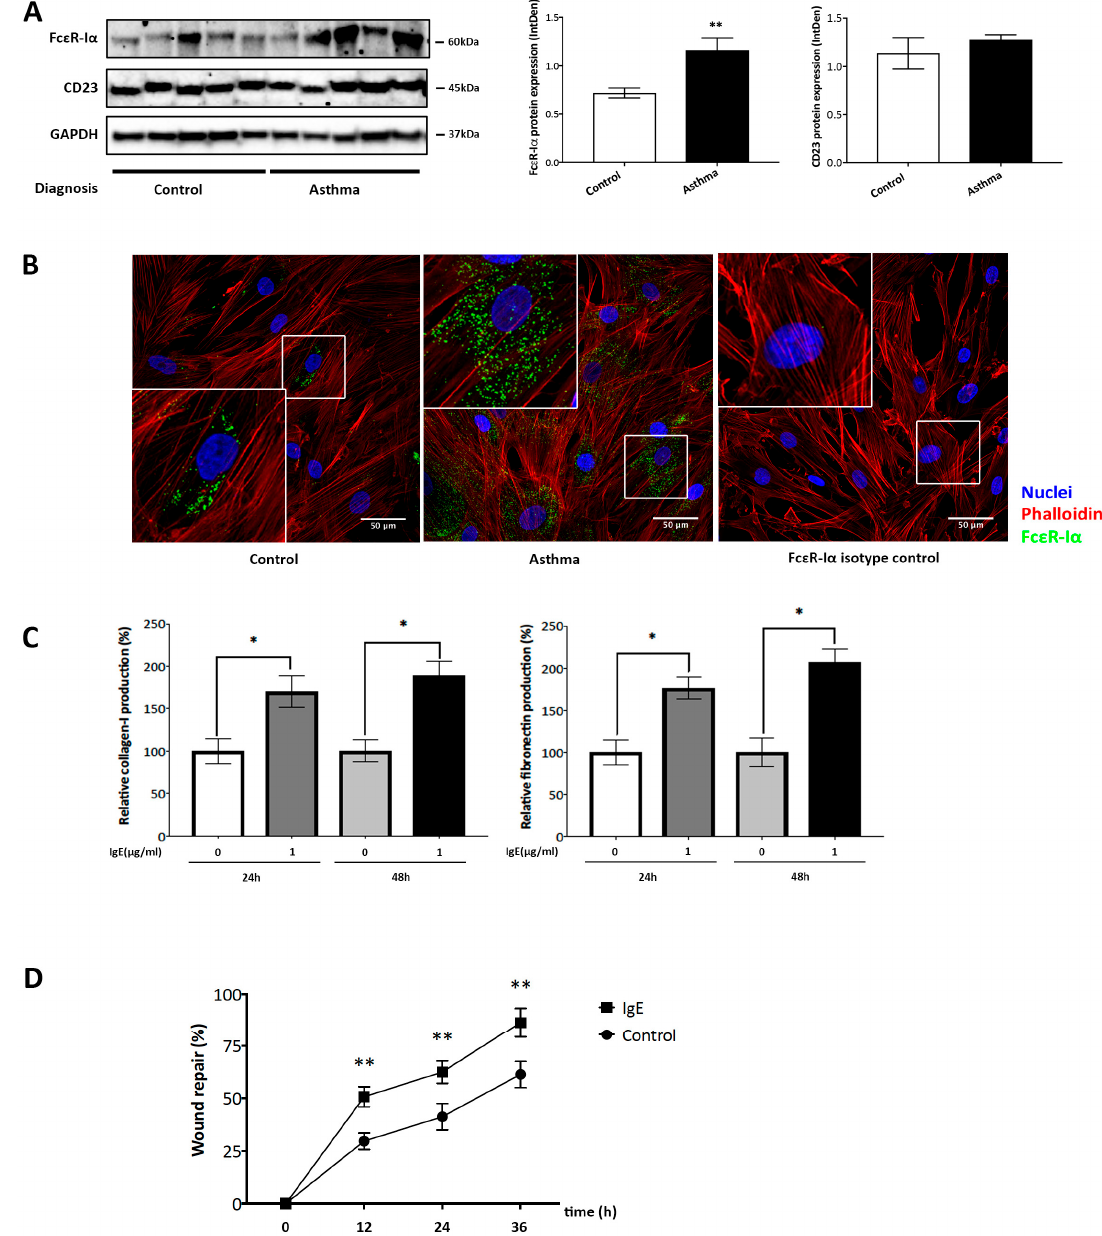
Figure 2. IgE receptor expression, IgE stimulated ECM deposition, and ASMC migration. ( A ) Western blot analysis of Fc ε R-I α and Fc ε R-II expression in ASMC from non-asthma controls ( n = 5) and asthma patients ( n = 5). Protein quantitation was performed by Image J software. Bars represent mean ± SEM. ** p < 0.01. ( B ) Representative confocal microscopy images of Fc ε R-I α and Fc ε R-II expression by ASMC of non-asthma and asthma patients: Fc ε R-I α -FITC (green). TRIC-Phalloidin (red) for F-actin and DAPI (blue) for nuclei. (600X magnification in enlarged boxes) Similar results were obtained in all other cell lines. ( C ) Cell-based ELISA assessed IgE-induced deposition of collagen type-I and fibronectin by asthmatic ASMC at 24 and 48 h. Bars represent mean ± SEM of quadruplicated measurements performed in ASMC of asthma patient ( n = 5), * p < 0.05. ( D ) Cell migration was assessed by measuring the width of a wound at 12, 24, and 36 h in the absence (control) or presence of IgE. Data points represent mean ± SEM from five independent experiments performed in cells obtained from five asthma patients. ** p < 0.01. Detailed images are presented in Appendix A Figure